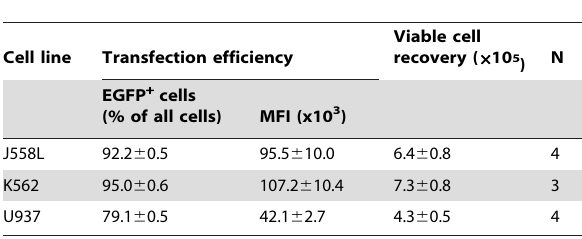
Table 1. Transfection efficiencies and viable cell recovery in suspension cell lines.